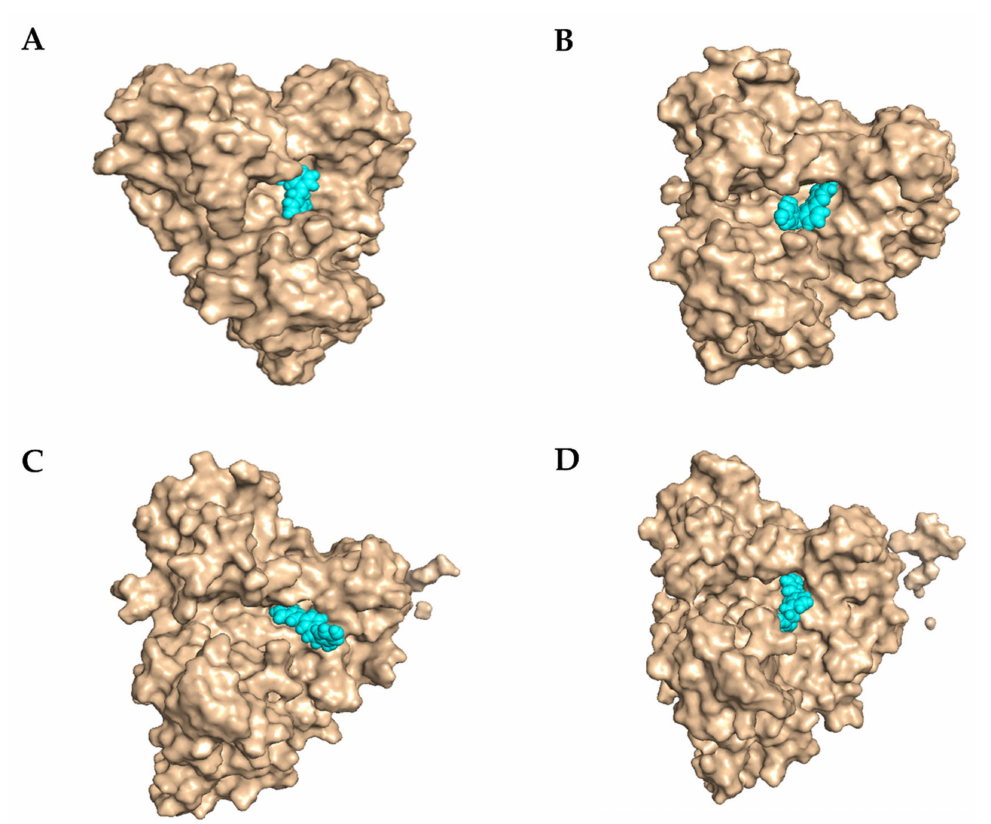
Figure 9. Surface of leishmanin with L2 ( A ) at 0 ns. ( B ) at 6 ns;( C ) at 8 ns; ( D ) at 10